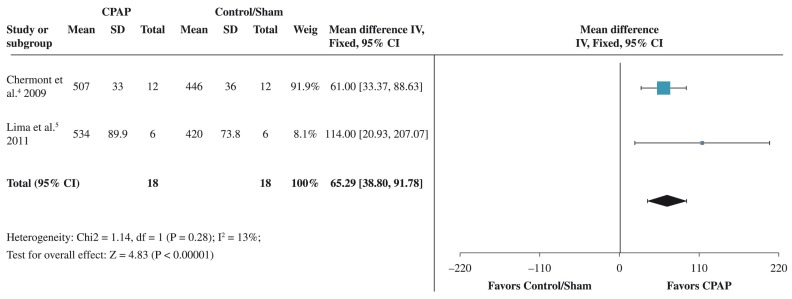
Forest plot of the results of the meta-analysis. Comparison of
intervention using positive pressure with CPAP versus a control/ sham group
to test the outcome. The values shown are the average effects (difference
between means) with a confidence interval of 95%. The average result was
calculated using a fixed-effect model.